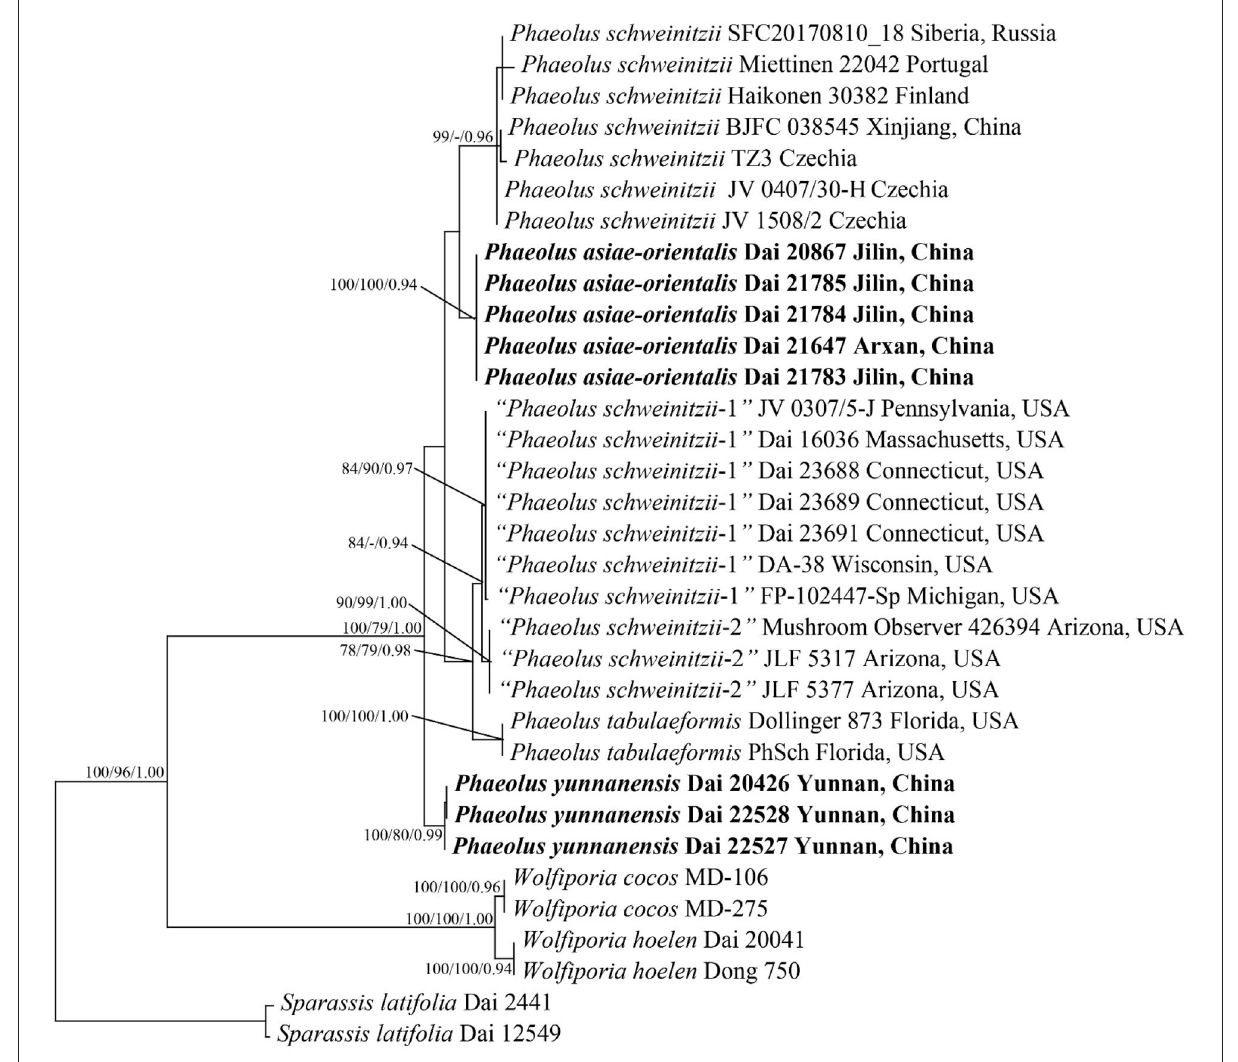
FIGURE1 Phylogeny of Phaeolus generated by maximum parsimony based on a dataset of ITS + nLSU. Branches are labeled with bootstrap values (MP/ML) higher than 75% and posterior probabilities (BI) more than 0.90, respectively. New taxa are in